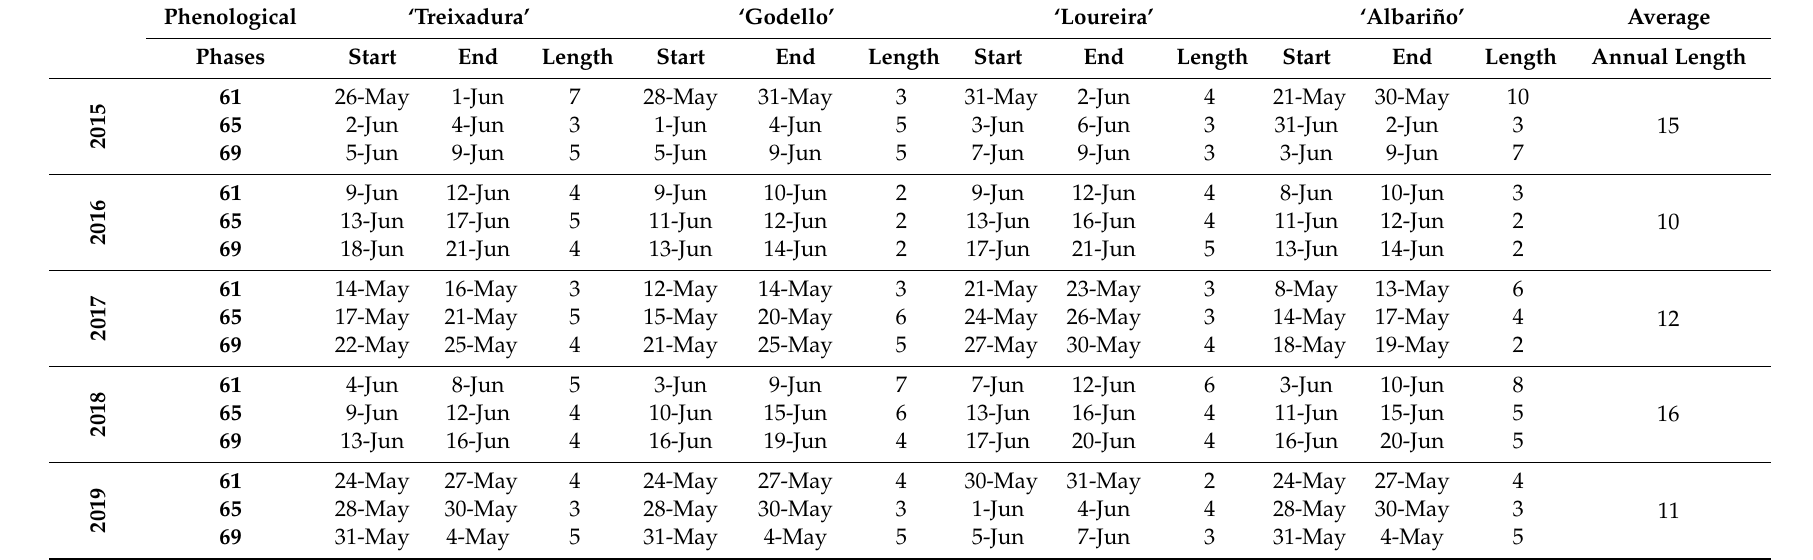
Table 1. Start, end and length of the phenophases 61 (Beginning of flowering: 10% of flower caps fallen), 65 (Full flowering: 50% of flower caps fallen) and 69 (End of flowering) during the stage 6 (flowering), and annual average